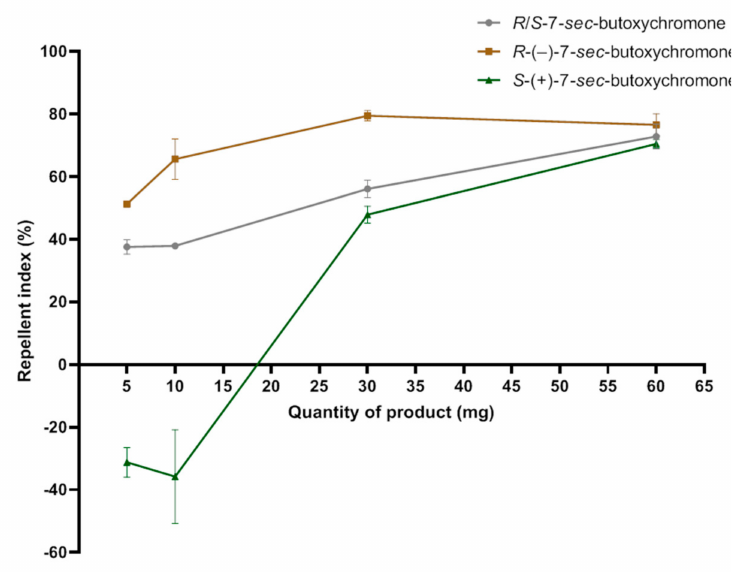
Figure 5. Repellent effects (SD) of racemic butoxychromone ( 10 ) and its two enantiomers: R -( − )-7- sec -butoxychromone ( 14 ) and S -(+)-7- sec -butoxychromone ( 15 ) against Aedes albopictus .